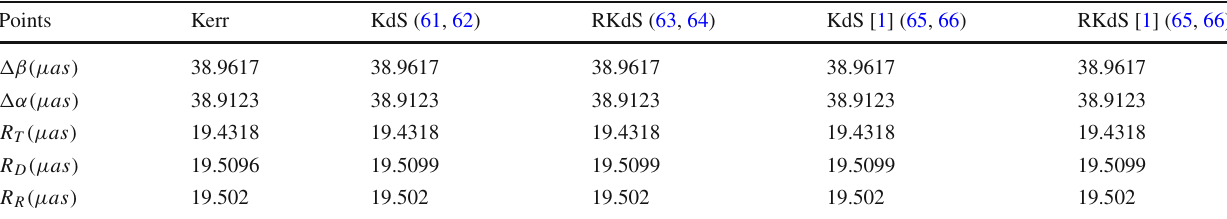
Table 1 Points evaluated for θ = 16 ◦ , a = 0 . 5 and (cid:2) = 1 . 11 × 10 − 52 m − 2 . We have chosen (cid:2) = 1 . 11 × 10 − 52 m − 2 because cosmological